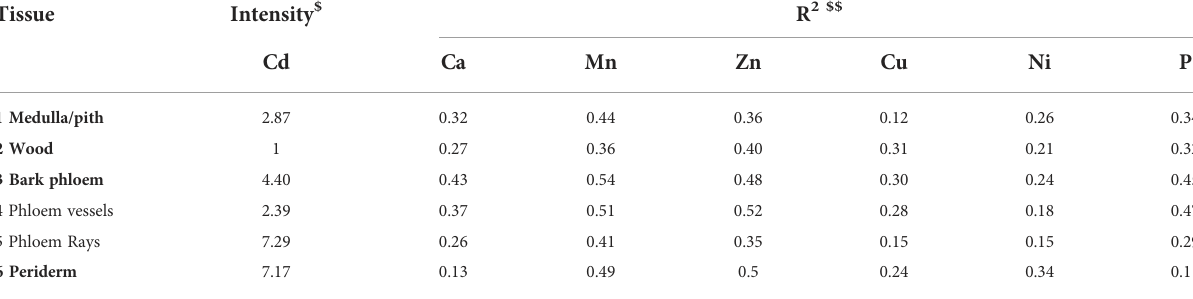
TABLE 4 Intensity of Cd in the different structures of the branch (T2) and R 2 of regressions to intensities of other elements detected by LA-ICP-MS. Tissue Intensity